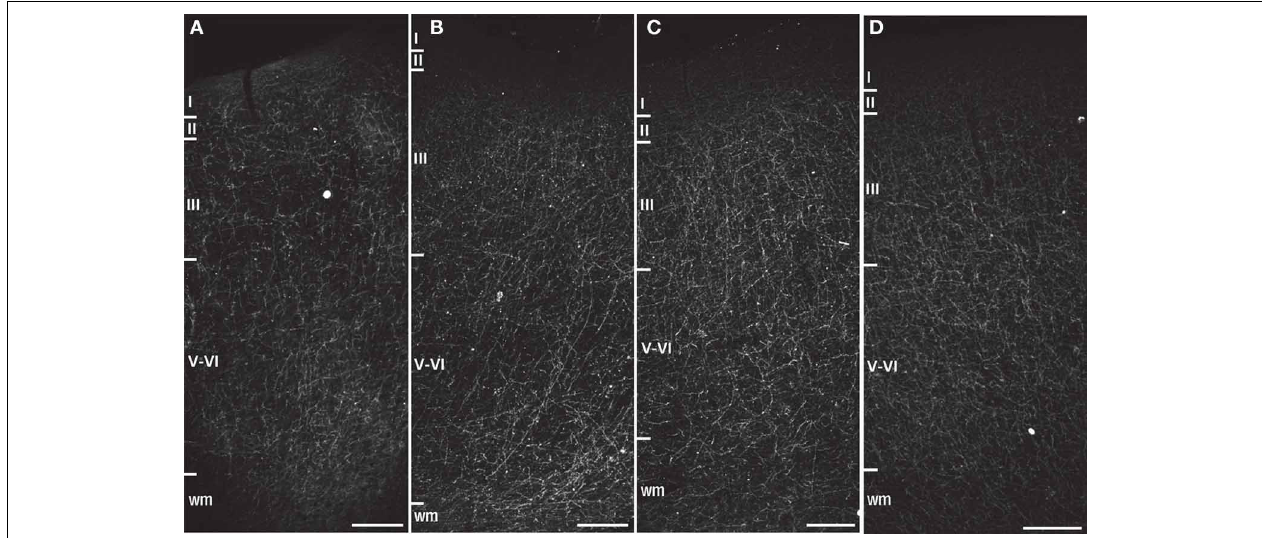
FIGURE 3 | Darkfield photomicrographs of NPY immunostaining in area 24 of (A) capuchin, (B) baboon, (C) gorilla, and (D) chimpanzee. Roman numerals indicate cortical layers, wm, white matter. Scale bars = 250 μ m.